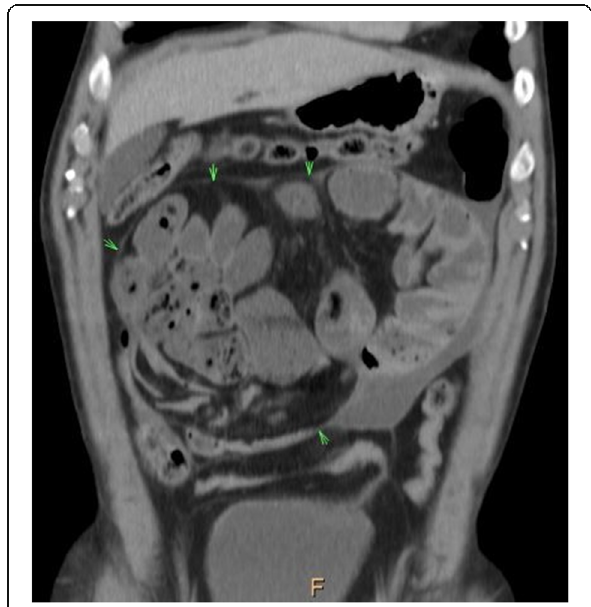
Fig. 2 Coronal reformatted image from contrast-enhanced CT of the abdomen demonstrating the thin peritoneal layer encapsulating the dilated small bowel loops